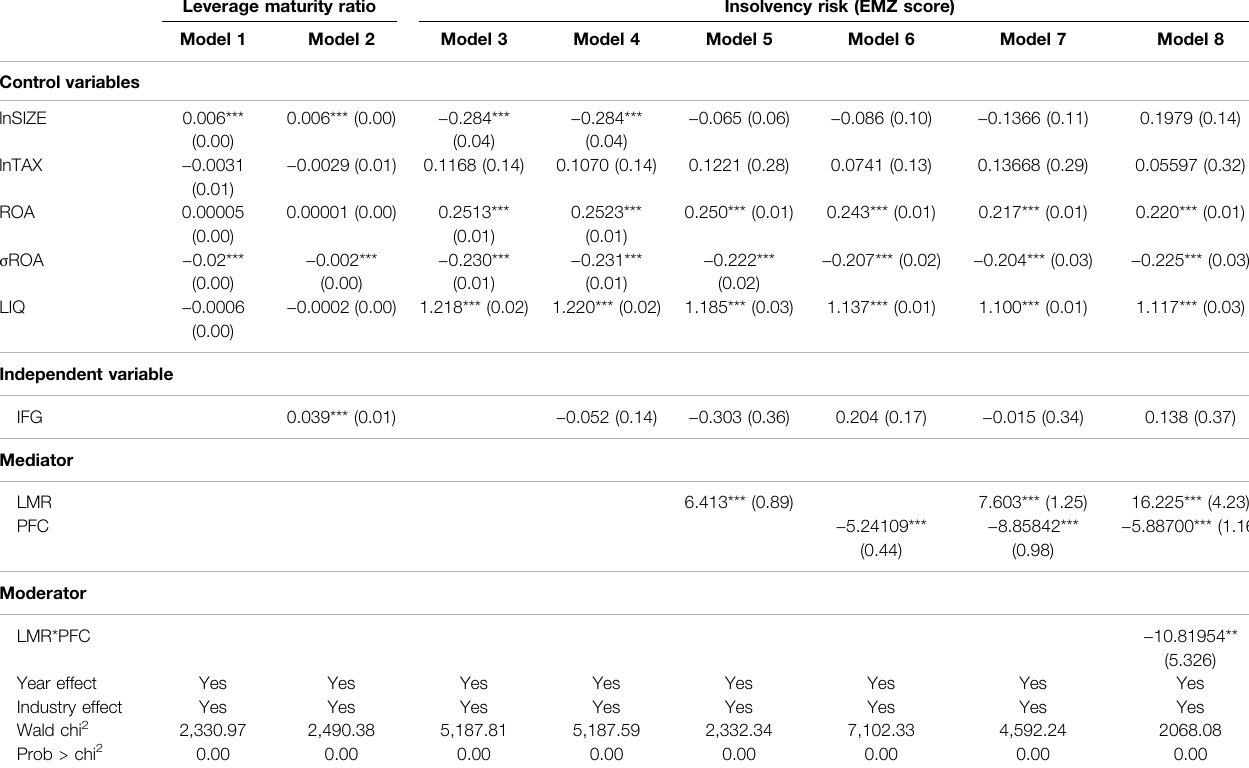
TABLE 8 | Hierarchical FGLS regression results with IFG as